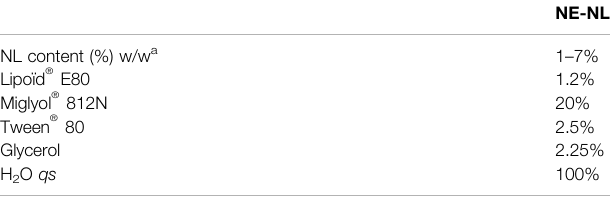
TABLE 1 | Composition of NEs loaded with acid-based NLs.